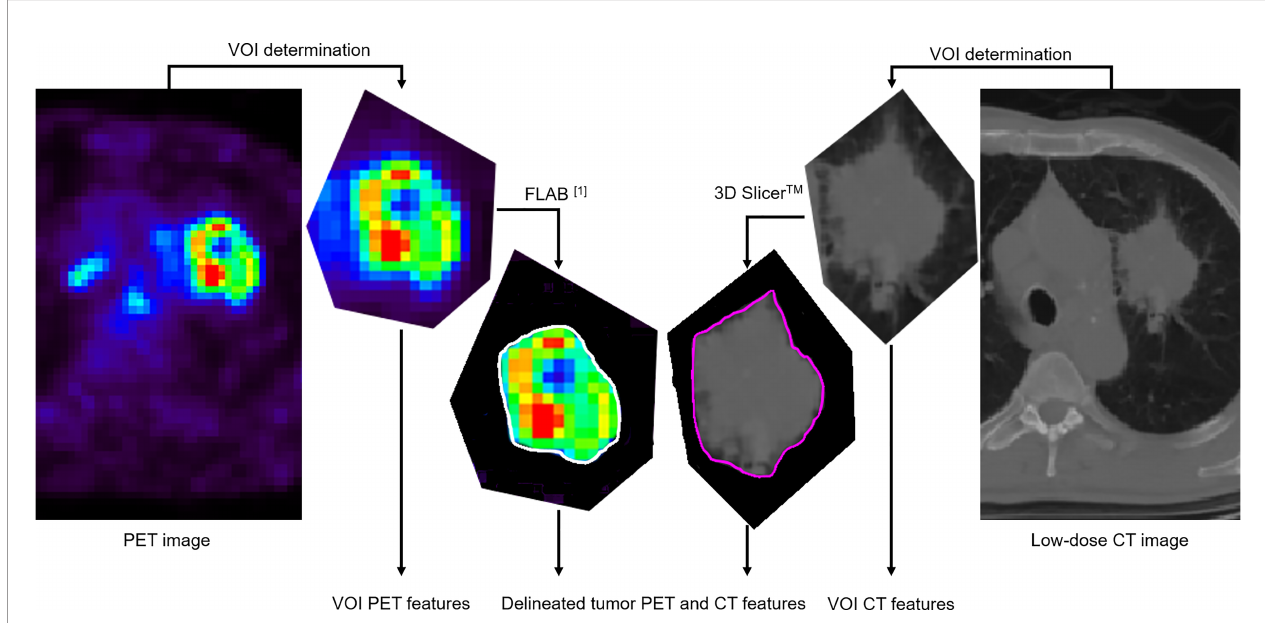
FIGURE 1 | Both PET and low-dose CT images of the primary tumor are processed in the same manner: a volume of interest (VOI) containing the tumor is fi rst manually determined. Radiomic features are extracted from this VOI (denoted “ VOI features ” ). Then, segmentation of the tumor volume is carried out within the VOI with a (semi)automated algorithm. Radiomic features are then extracted from the delineated volume (this is the usual work fl